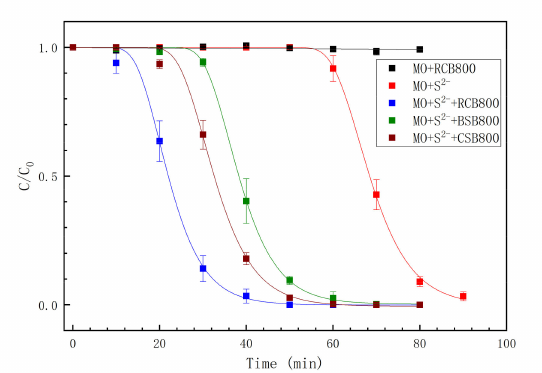
Figure 4. Degradation of MO by sulfide with different biochar catalysts: degradation of MO (0.5 mM) by sulfide (6 mM) with RCB800, BSB800, and CSB800 and control experiments without biochar or sulfide. The dosage of materials was 100 mg/L, pH = 7.4, and the temperature was 30 ◦